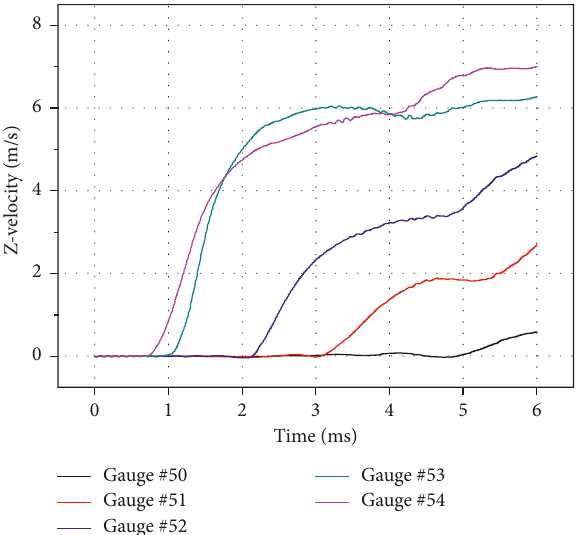
Figure 16: Velocity-time history of Gauges.